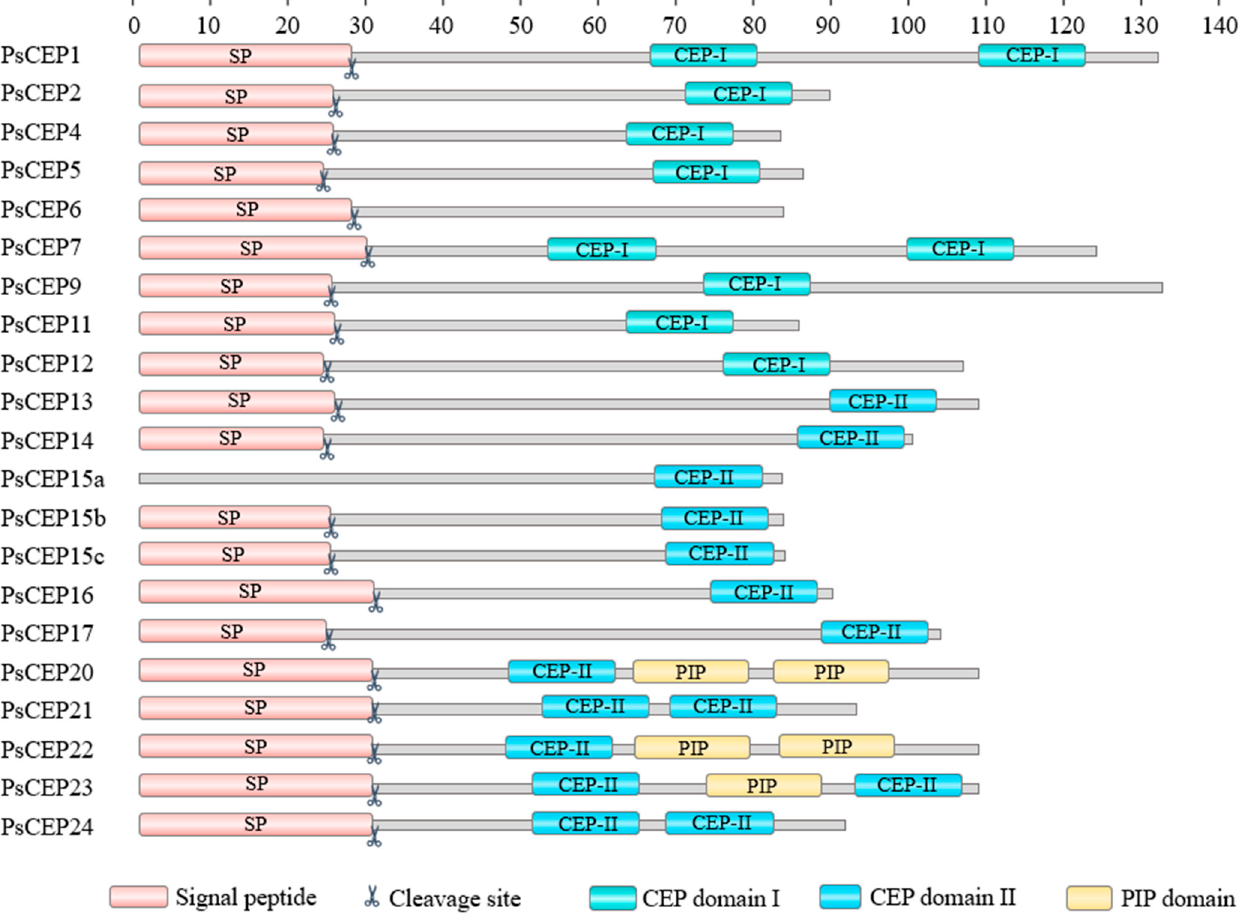
Figure 6 . Structural organization of the PsCEP proteins. The conserved functional domains (CEP-I, CEP-II, PIP), N-terminal signal peptide (SP) and putative cleavage site (CS) are shown.